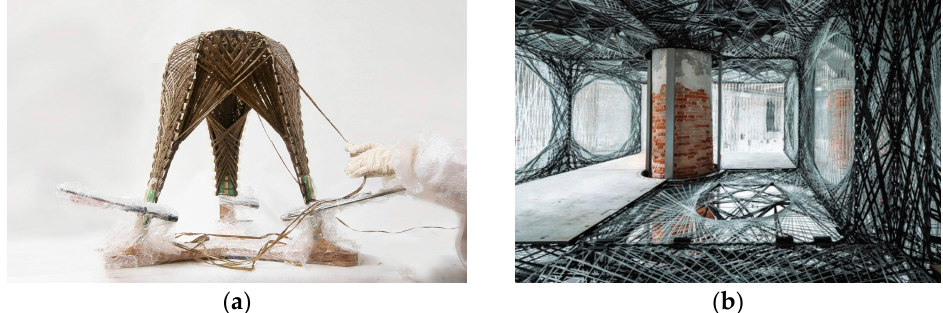
Figure 2. State of the art: ( a ) FlexFlax stool embedded winding frame [13]; ( b ) hybrid timber–fibre slab of the Maison Fibre [11].